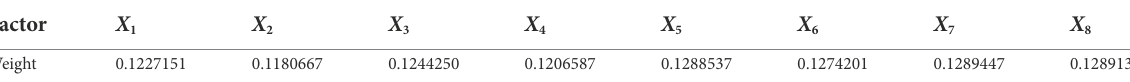
TABLE 5 The weight of each influential factor.